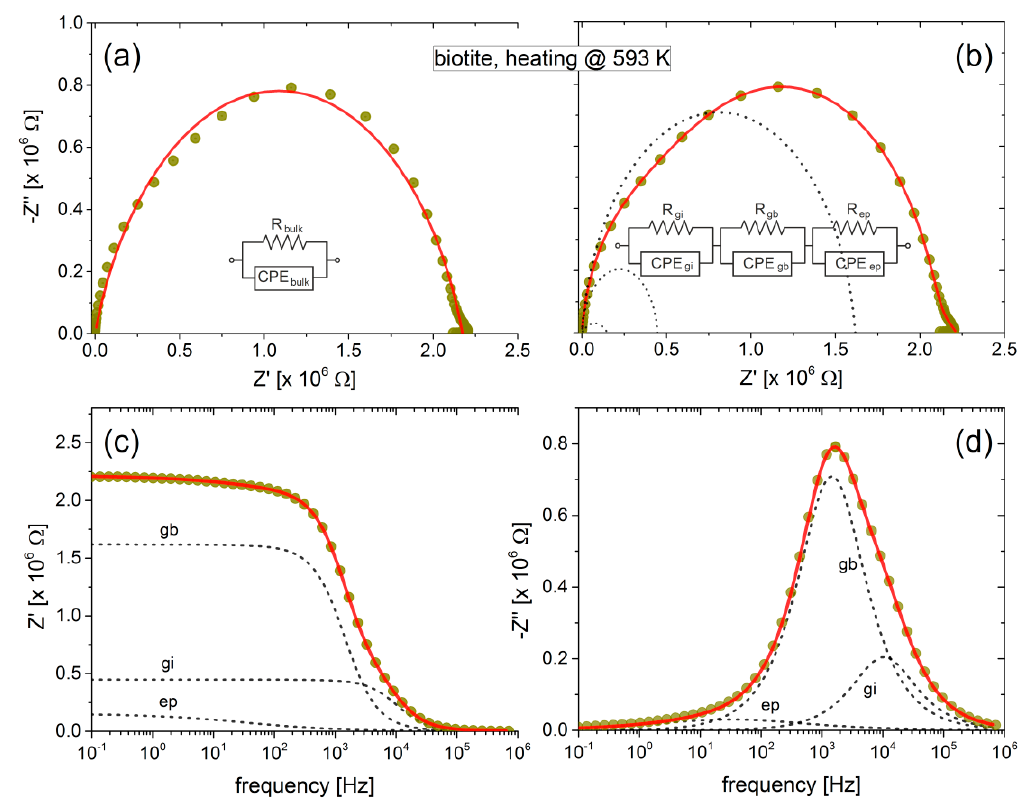
Figure 3. Cole-Cole plot of biotite at 593 K during the heating procedure (refer to Figure 1b). In ( a ), the solid (red) line corresponds to the fitting of data with a resistor (R bulk ) and a constant phase element (CPE bulk ) in parallel. In ( b ), three R-CPE circuit elements in series have been used to fit the same experimental data. The three dashed semicircles correspond to each one of the R-CPE circuits. In ( c , d ), the real and imaginary part of impedance Z has been plotted as a function of frequency. Dashed lines correspond to the contribution of each R-CPE circuit.